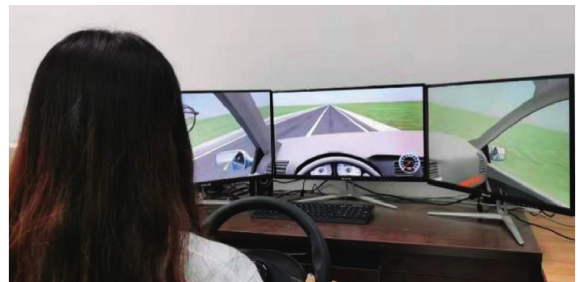
Figure 1: Driving